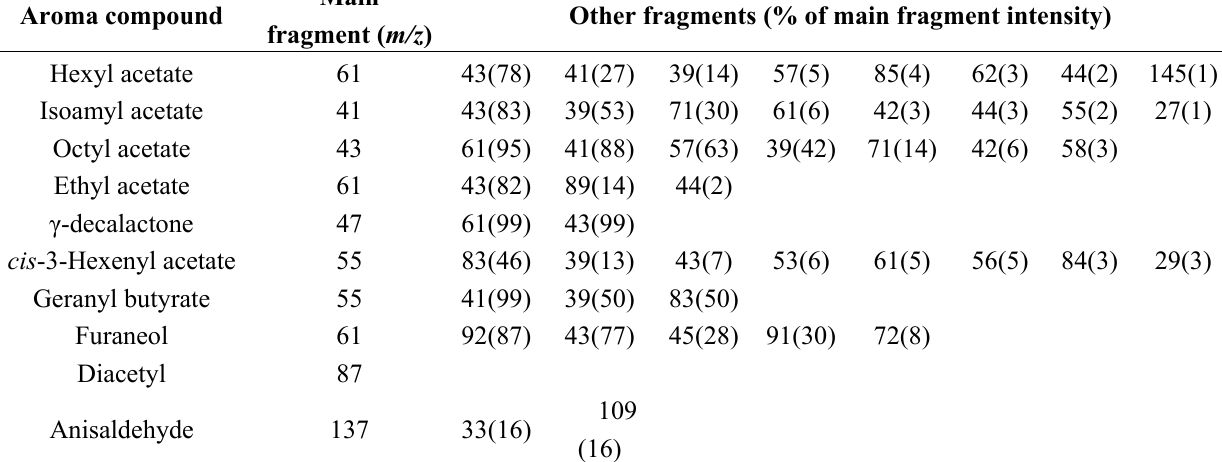
Table 2. Fragmentation patterns of yogurt main aroma compounds, determined during in vitro measurements by PTR-MS.